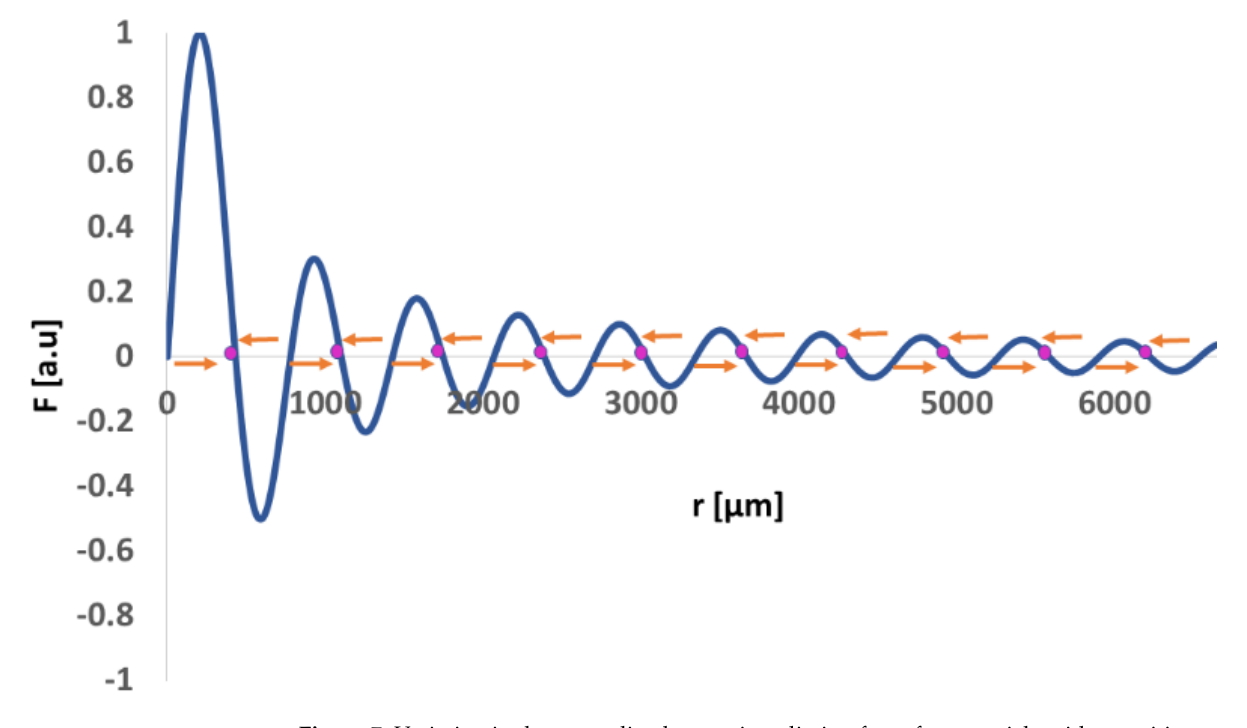
Figure 7. Variation in the normalized acoustic radiation force for a particle with a positive acoustic contrast factor along the radius of a cylindrical resonator, with r = 0 corresponding to the center of the resonator. The pink dots represent the nodal areas of the wave where an accumulation of triamcinolone acetonide particles was detected. The orange vectors represent the direction of the acoustic radiation force applied on micro particles.